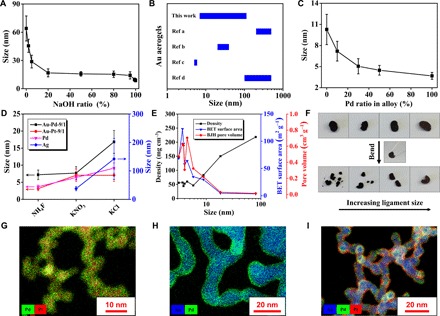
Versatile manipulation of NMAs.(A) Tailor the ligament size of gold gels by introducing NaOH/NaCl hybrid salts. (B) Ligament size of gold aerogels from different references [references (Ref) a to d corresponds to (13), (9), (31), and (14), respectively]. (C) The ligament size variation with Au/Pd ratio. (D) Ligament size modulation of Au-Pd, Au-Pt, Pd, and Ag gels using different salts. (E) The dependence of density, Brunauer-Emmett-Teller (BET) surface area, and Barrett–Joyner–Halenda (BJH) pore volume of aerogels versus ligament size. (F) Demonstration of the size-dependent mechanical properties of aerogels by bending with a tweezer. From left to right are Au-Ag-NH4F (5.8 ± 0.7 nm), Au-NH4SCN (8.9 ± 2.5 nm), Au-NH4NO3 (18.2 ± 4.0 nm), and Au-NaCl (64.0 ± 13.3 nm), respectively. (G to I) STEM–energy-dispersive x-ray spectroscopy (EDX) of three alloy gels with (G) homogeneous and (H and I) core-shell architectures.